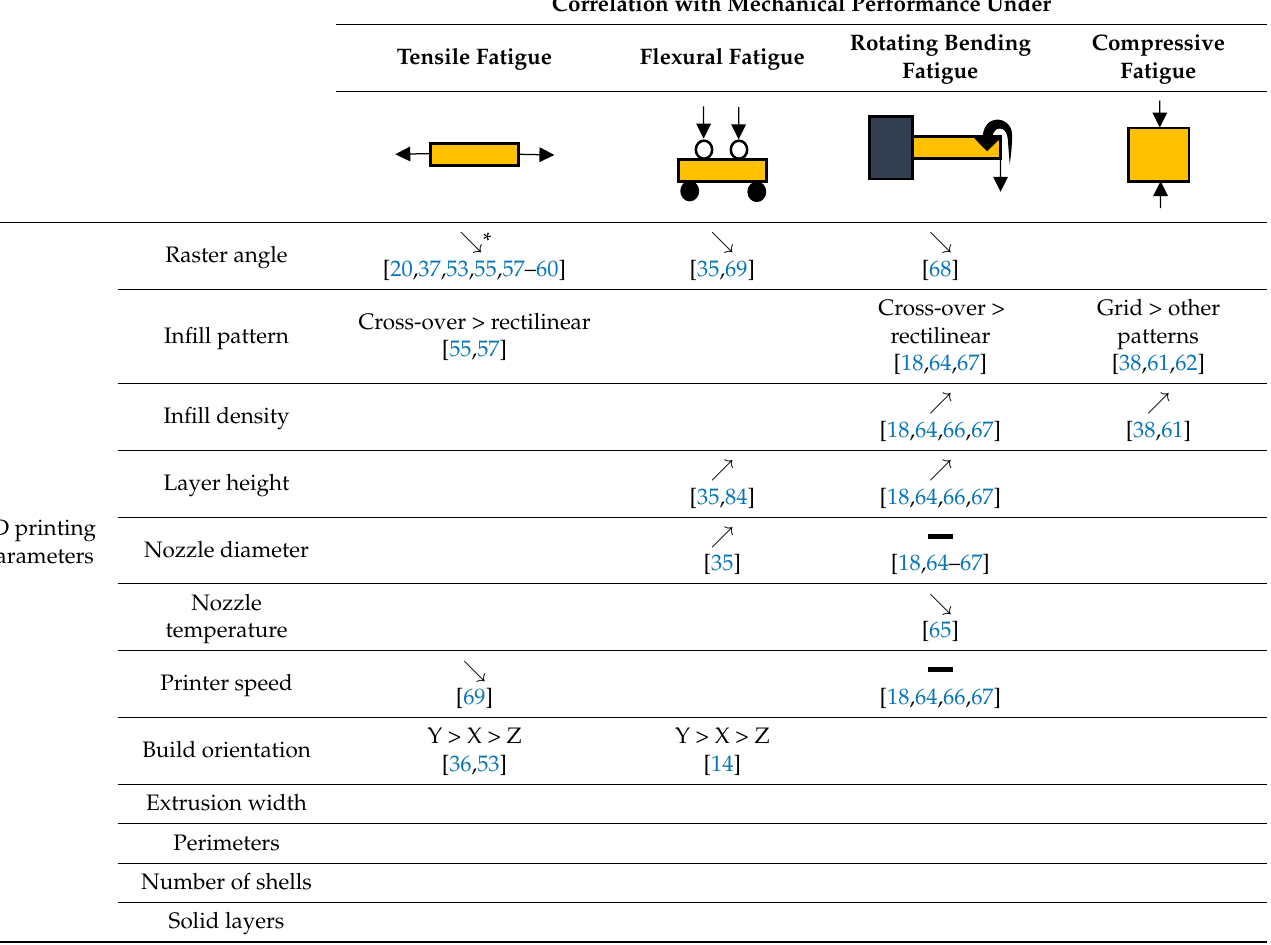
Table 3. Correlation between 3D printing parameters and the fatigue performance of FFF prints for different loading types based on the results extracted from the literature. Correlations: direct ( (cid:37) ), 24 of 28 inverse ( (cid:38) ), unspecific ( ), and unstudied (blank cell). Correlation with Mechanical Performance Under Rotating Bending Compressive Rotating Bending Tensile Fatigue Flexural Fatigue Tensile Fatigue Flexural Fatigue Compressive Fatigue Fatigue Fatigue